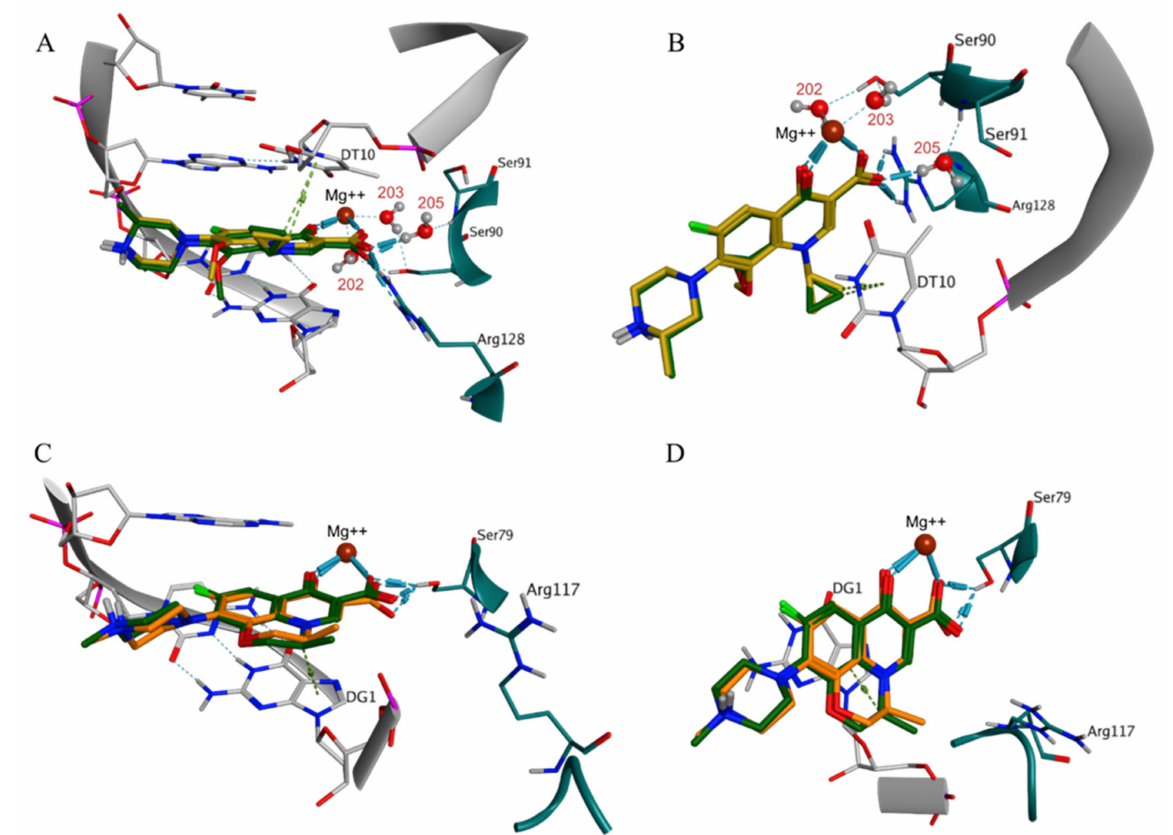
Figure 2. Redocking of the native ligands in the active sites of the protein-DNA-drug complexes presented in two different views: ( A , B ) DNA gyrase–(S)-gatifloxacin (X-ray pose in yellow, the best redocked pose in dark green); and ( C , D ) DNA topoisomerase IV–(S)-levofloxacin (X-ray pose in orange, the best redocked pose in dark green). The indices of the bridging water molecules HOH202, HOH203, and HOH205 are shown in red. The DNA molecules, including the nucleotides thymine 10 (DT10) and guanine 1 (DG1), are shown in grey; the proteins and their amino acid residues (Ser90, Ser91, Ser79, Arg128, and Arg117) are shown in teal; and the Mg++ ion is shown in brown. The intermolecular ionic and H-bond interactions are displayed with blue cylinders, while arene-H interactions—with light green